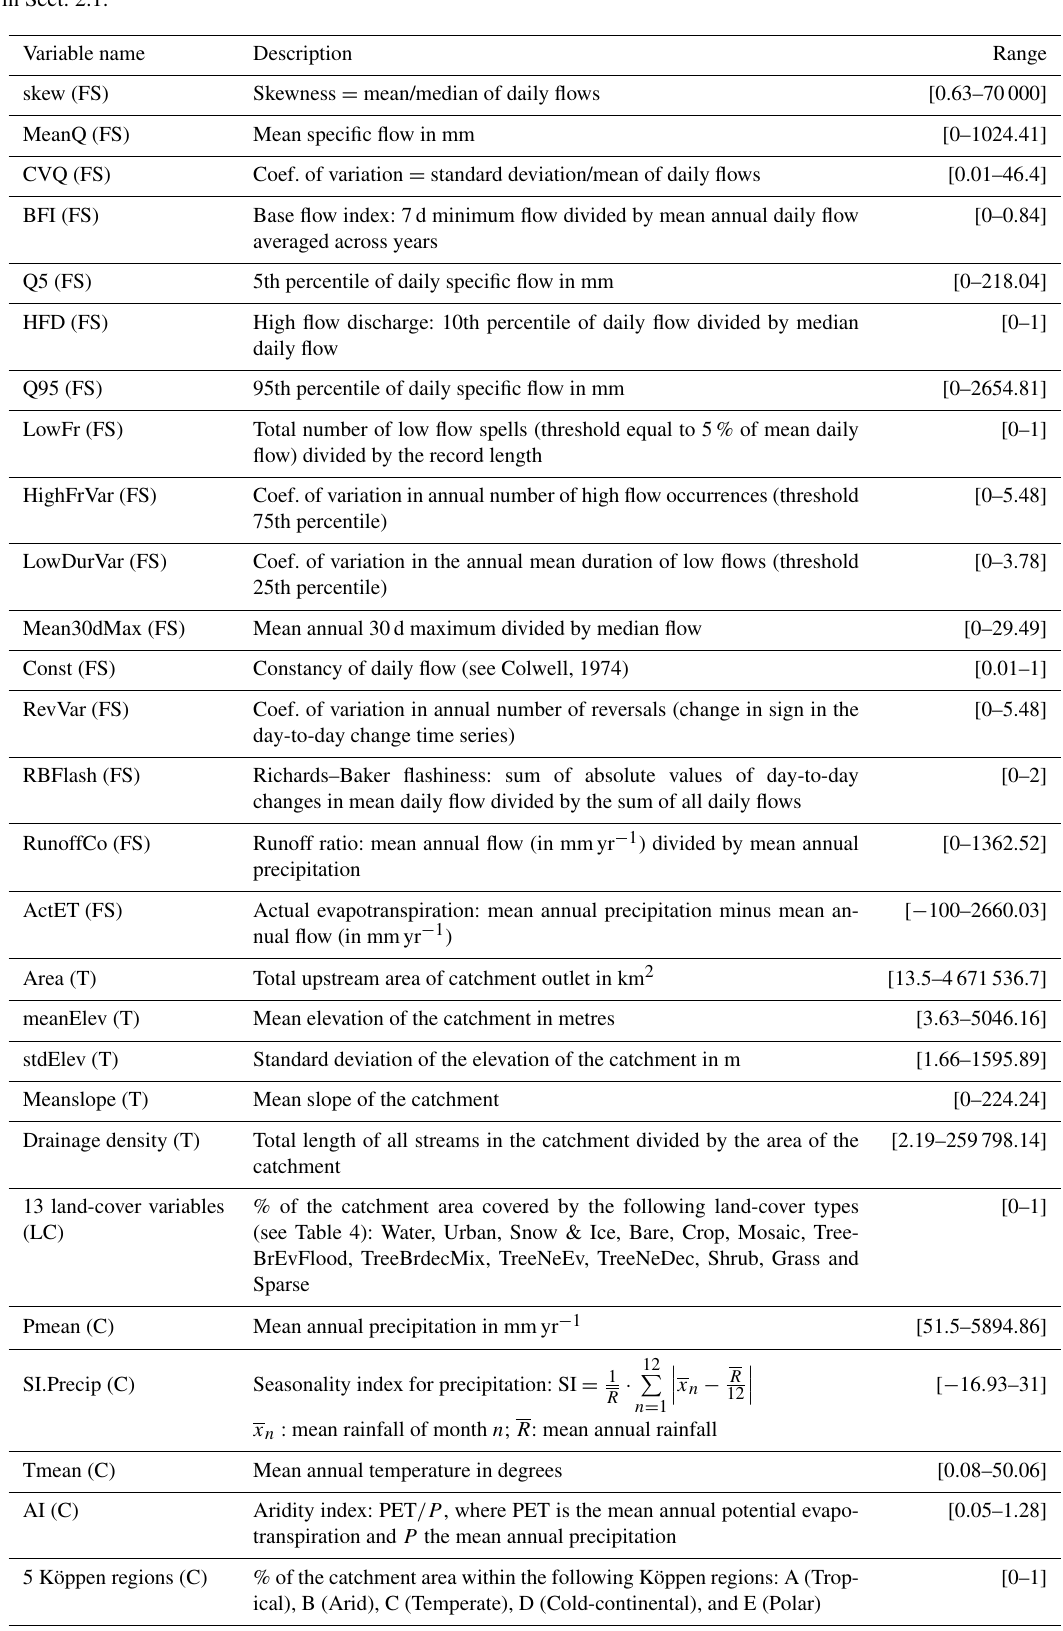
Table 5. Flow signatures (FS) from observed time series and physiographic descriptors (T: topography; LC: land cover; C: climate) from databases in Sect.